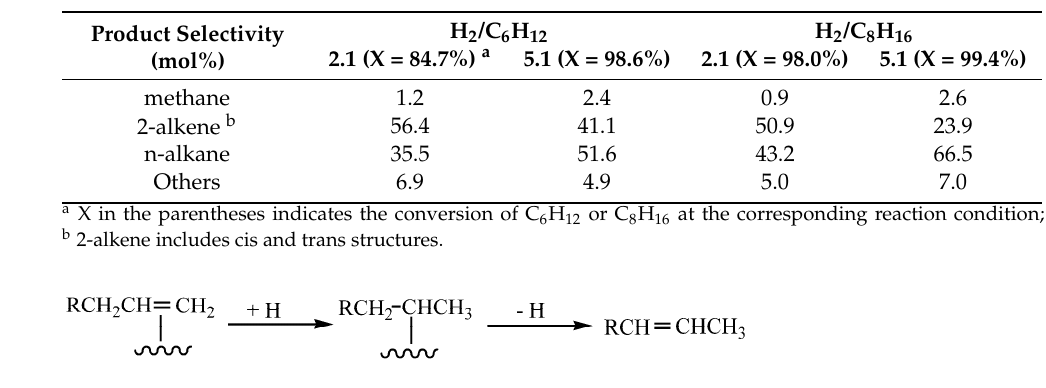
Figure 2. The product distribution of the light alkene reaction (T = 533 K, p = 0.8 MPa). ( a ) C 2 H 4 in H 2 atmosphere. ( b ) C 3 H 6 in H 2 atmosphere.